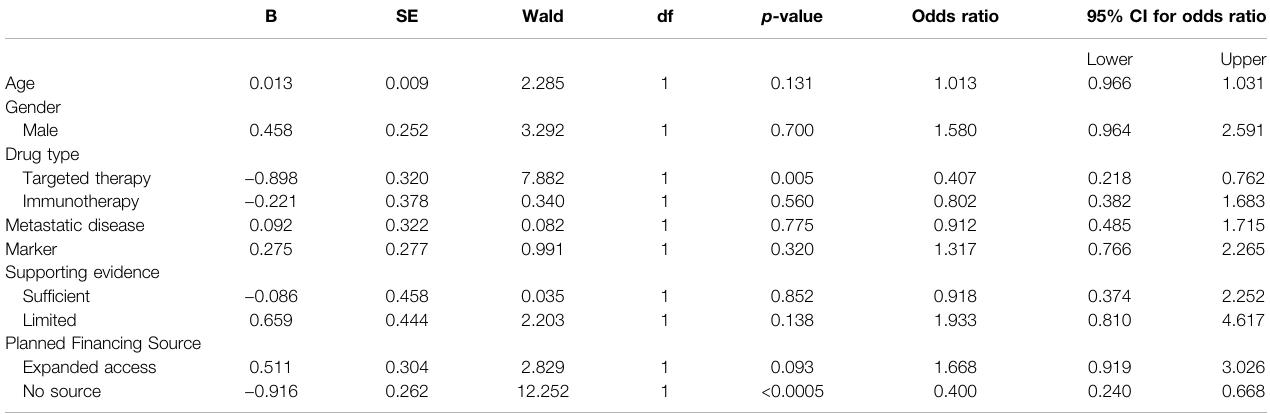
TABLE3| Multivariatelogisticregressionpredictingthelikelihoodoftreatmentinitiationbasedonage,gender,drugtype, metastaticdisease, markerortargetablemutation, supporting evidence and planned fi nancing source ( n (cid:1) 708).